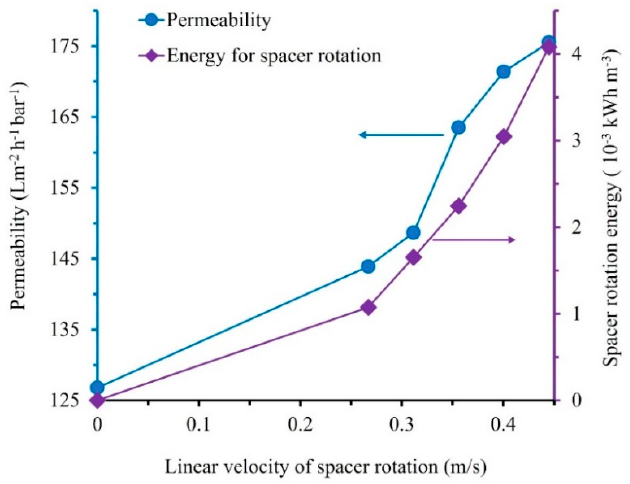
Figure 8. The energy consumption of the rotary spacer system operated under variable rotation